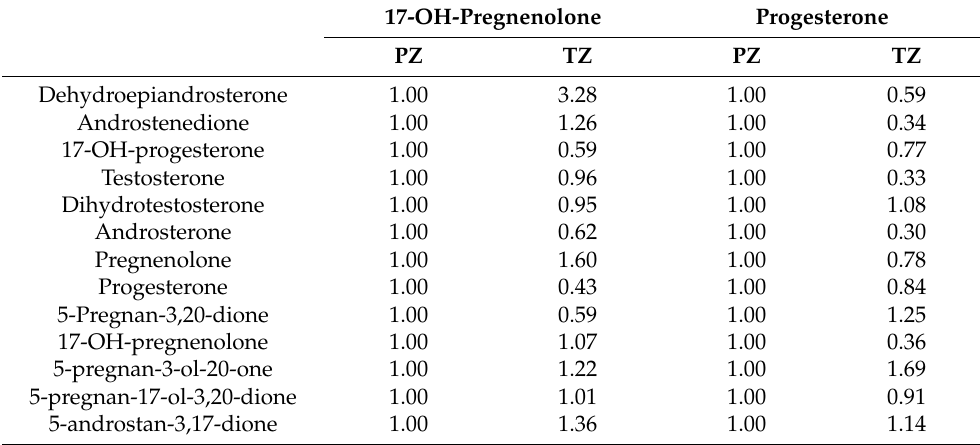
Table 2. Comparison (fold difference) of net steroid changes following 60 min incubation of 17- OH-pregnenolone (2 µ g/mL) and progesterone (2 µ g/mL) with human prostate cancer tissue ho- mogenates of peripheral zone (PZ) and transition zone (TZ). Results are expressed as fold changes compared to PZ steroid levels following incubation with 17-OH-pregnenolone or progesterone. No statistical differences were found between the steroid levels in different zones of the prostate tissues when incubated with either 17-OH-pregnenolone or progesterone.